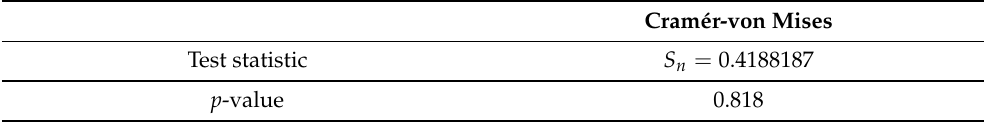
Table 8. GOF test for ˆ C θ